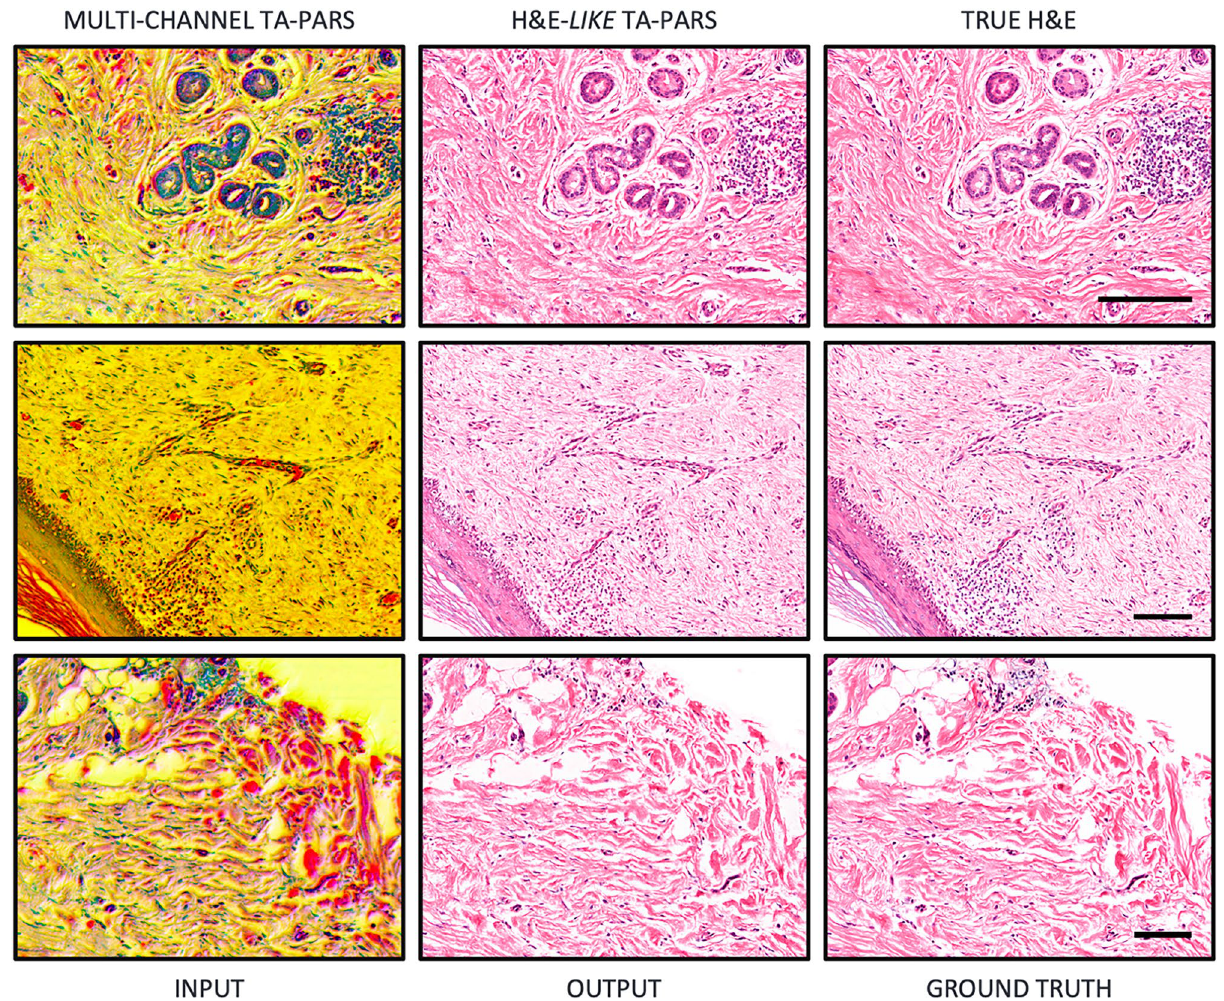
Figure 6. Virtual staining of TA-PARS images of human skin tissue slides. Here, the same images were used for training and testing the model, setting an upper bound to the model performance. Scale bar: 100